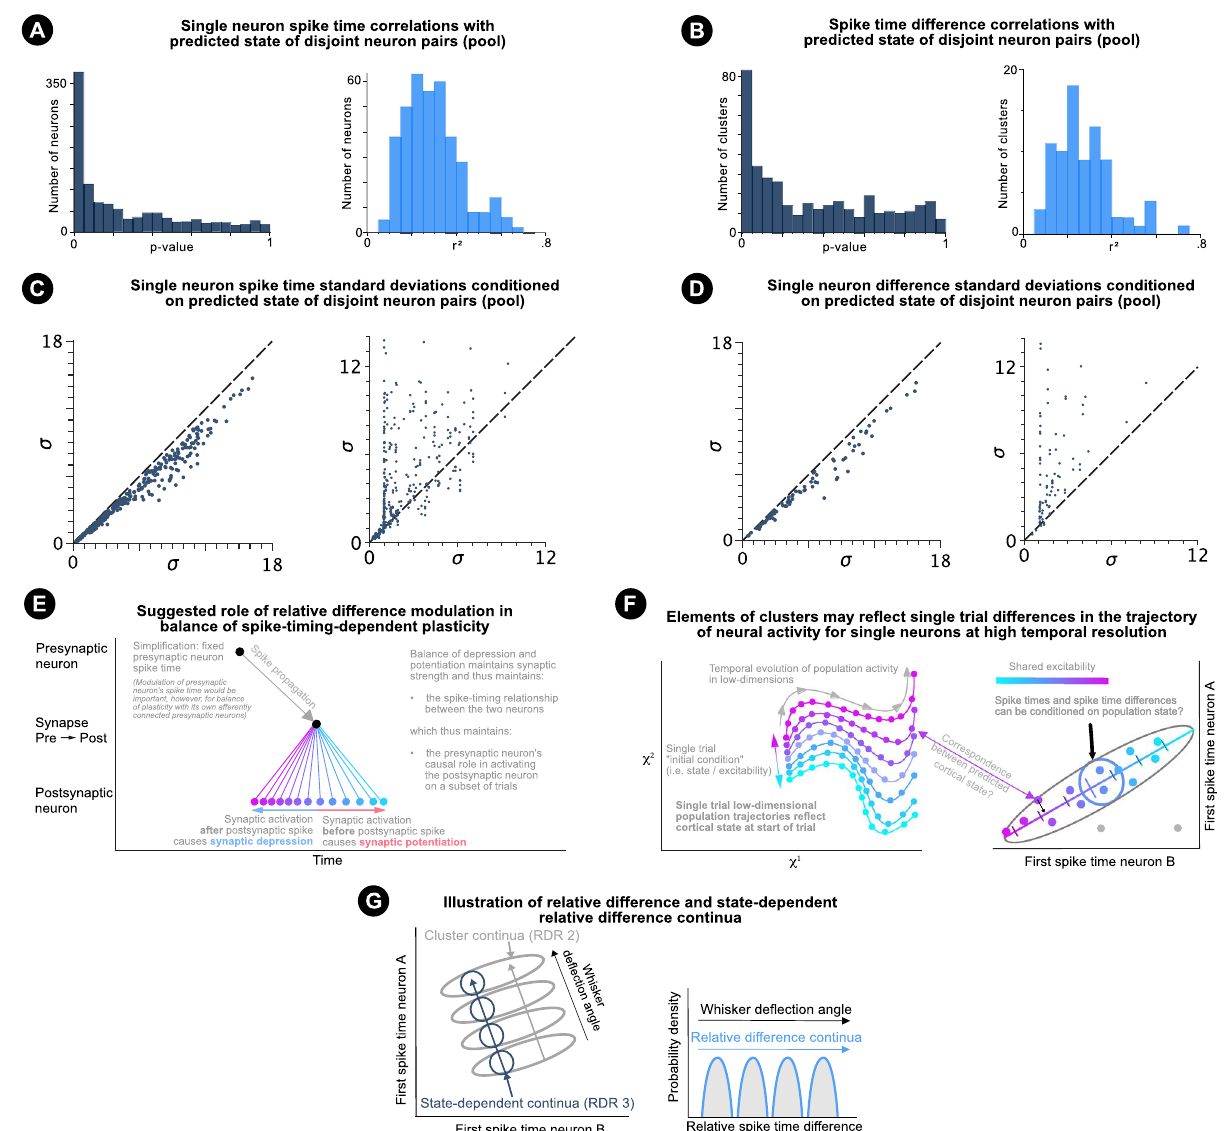
Figure 8. State-conditioned spike times and differences. Discussion. ( a ) Left: p -value histogram of correlations between predicted states of single correlated neuron pairs with the spike times of other correlated neuron pairs (clustered and unclustered pooled). Right: r-value histogram of statistically significant ( p < 0.05) correlations. ◦ ( b ) Same as ( a ) but for correlations with spike time differences with non- 45 correlation angles. ( c ) Left: variability comparison. X-axis shows the standard deviation of single neuron spike times within stationary and made-stationary clusters and correlated unclustered response distributions (pooled). Y-axis shows the standard deviations of spike times conditioned on the predicted state of single correlated neuron pairs, which do not share a common neuron. Right: Comparison of predicted state-dependent spike time variability predicted by factor analysis (x-axis) vs spike time variability conditioned on the predicted state of single correlated neuron pairs, which do not share a common neuron (y-axis). ( d ) Same as ( c ) but for correlations with spike time ◦ differences with non- 45 correlation angles. ( e ) Suggested role of relative difference modulation in balancing spike-timing-dependent plasticity. A fixed spike time is shown for the presynaptic neuron, although the figure explains why the presynaptic neuron’s spike time should also be modulated. ( f ) Illustration of possible correspondence between single trial variability in low-dimensional population dynamics and single trial spike times for correlated clusters. ( g ) Left: Illustration of continua of first spike time distributions, corresponding to first spike times (not relative differences) under RDR 2 (grey) and 3 (dark blue). Right: Illustration of continua of relative spike time difference distributions, which could correspond to RDR 2 or